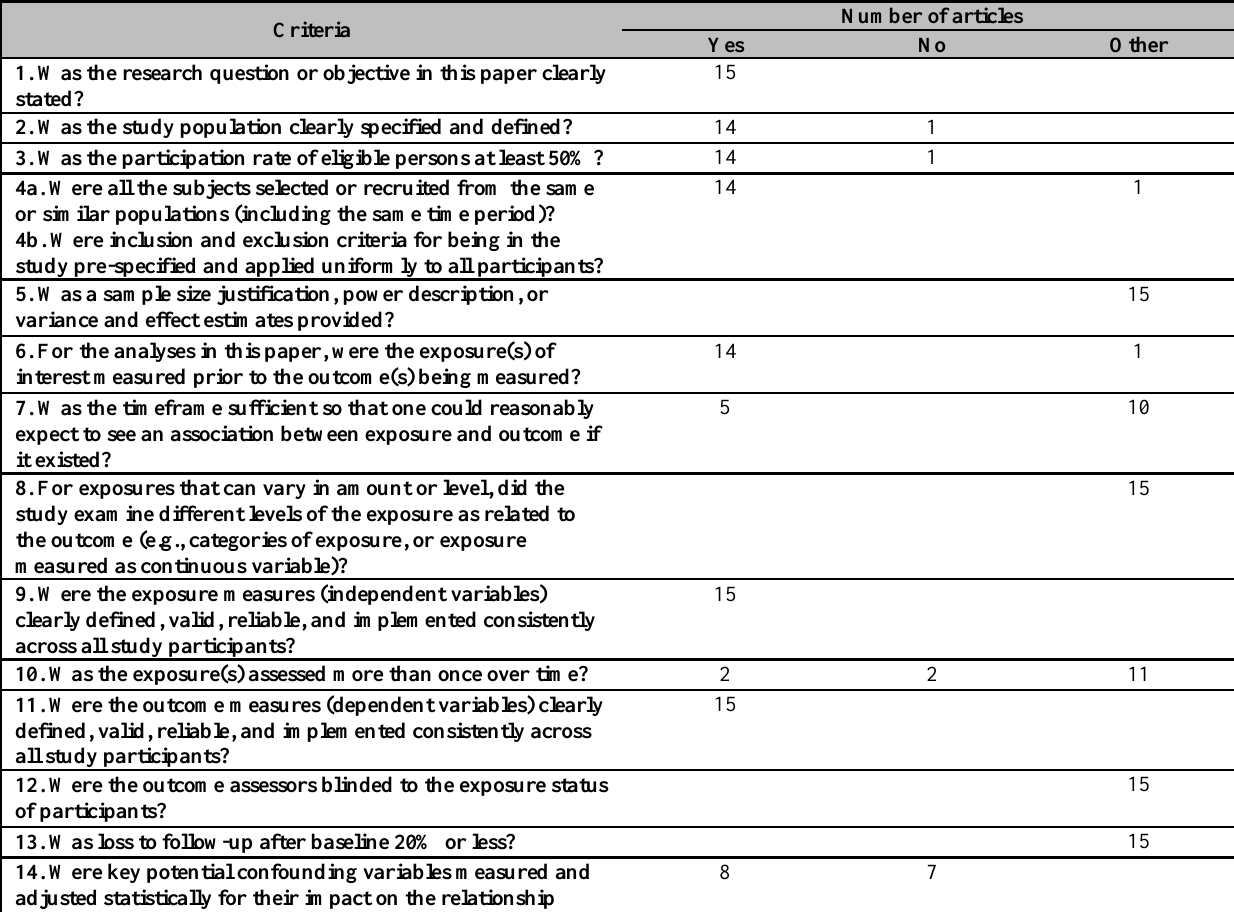
Table 1. Quality Assessment Tool for Observational Cohort and Cross-Sectional Studies